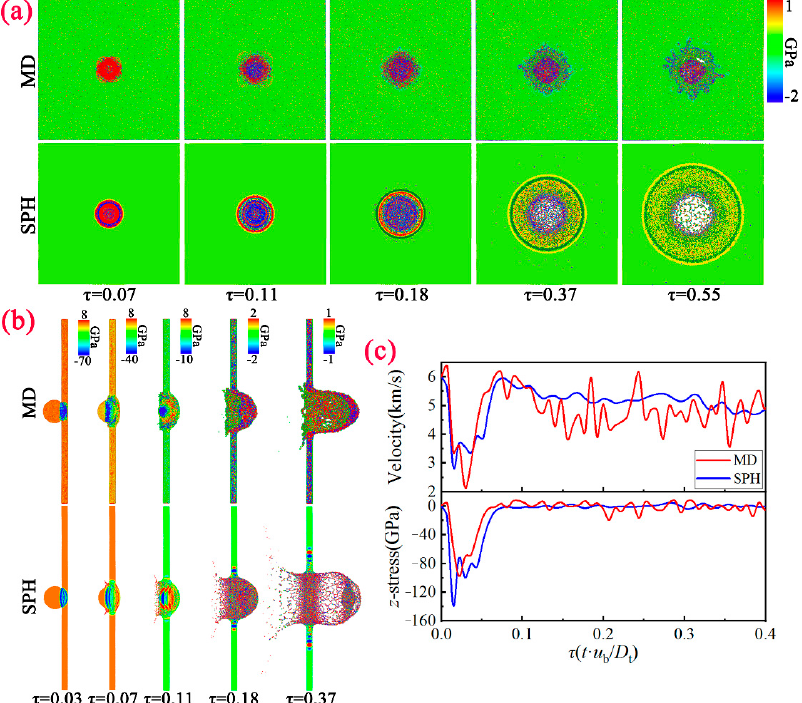
Figure 5. Views of the target pressure distribution ( a ) and the whole model z-stress distribution ( b ) between MD and SPH at different moments under u b = 6.0 km/s. ( c ) Comparison of the velocity and z-stress variation with time of feature particle between MD and SPH.